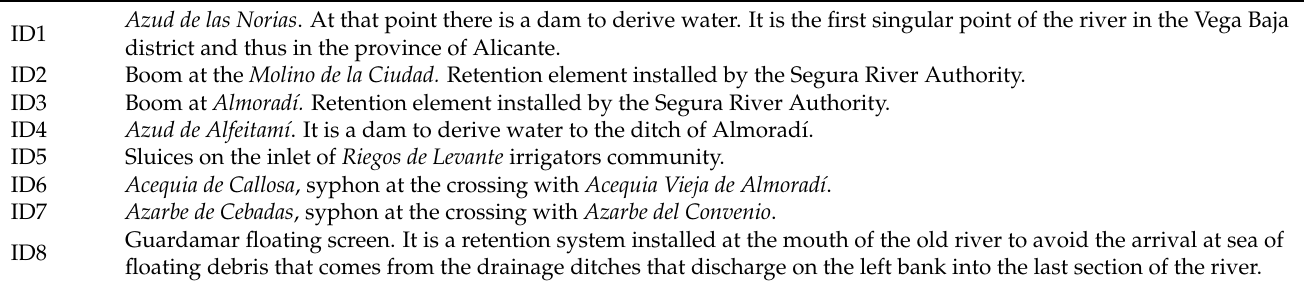
Table 1. Identification and description of the sampling points depicted in Figure 2.